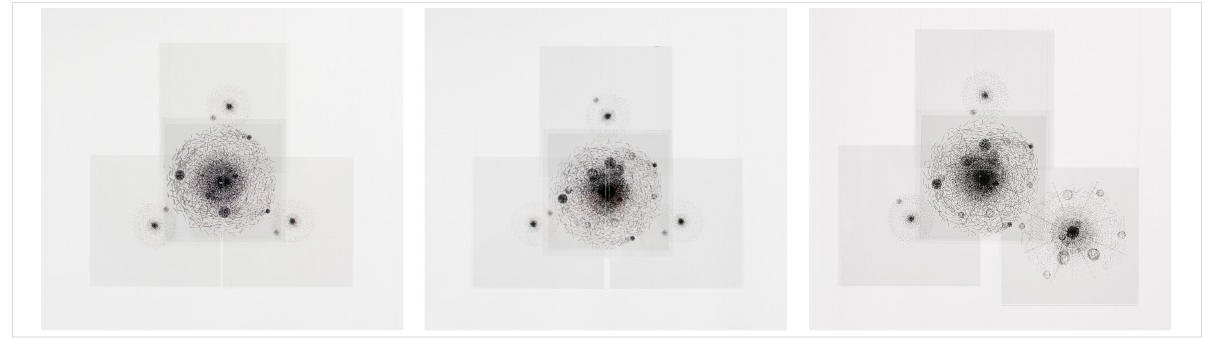
Figure 6: Hangings of methane (CH 4 ), fluoromethane (CH 3 F), and difluoromethane (CH 2 F 2 ) (from left to right) by Jette